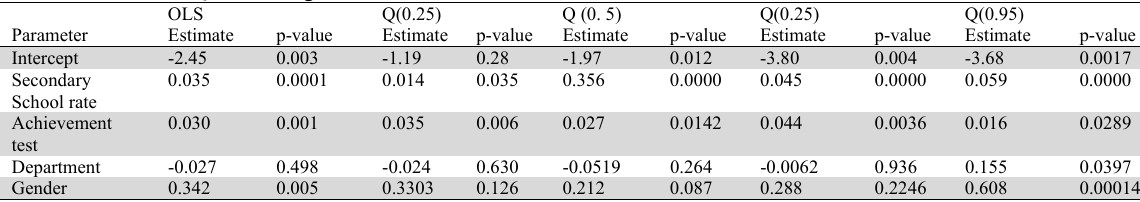
Results of OLS and Quantile Regression